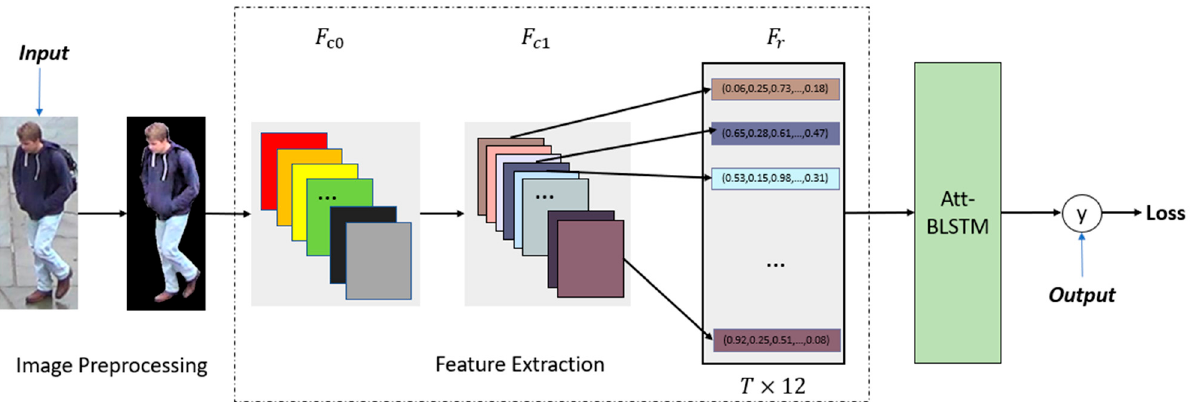
Figure 1. The framework of the model. The output y will be used to calculate the hard triplet loss, which will be men- tioned later.